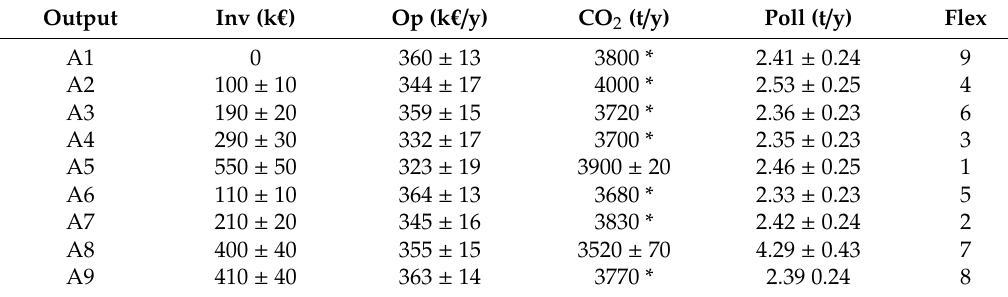
Table 7. LP2 outputs for the di ff erent